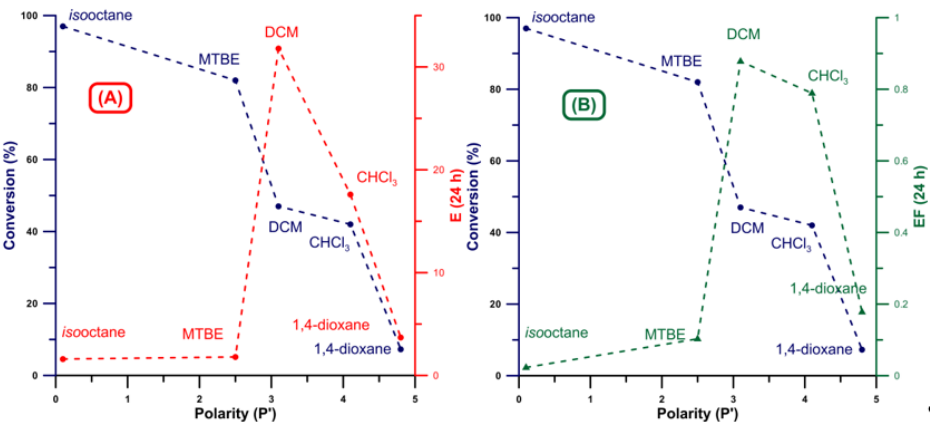
Figure 4. Correlation between the polarity of the cosolvent with conversion (% blue) and enantiose- lectivity quantified using either E (( A ), red) or EF (( B ), green) in the esterification of rac -ibuprofen with TEOF. Experimental conditions in Table 1.